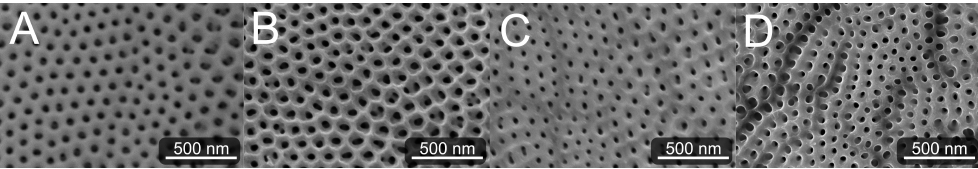
Figure 1. Scanning electron microscope (SEM) images of examined pristine TNSs ( A ) and TNSs implanted with 8 × 10 14 ions · cm − 2 ( B ), 1 × 10 16 ions · cm − 2 ( C ), and 2 × 10 16 ions · cm − 2 ( D ). The inner tube radius decreases from ( A – D ) due to irradiation-induced viscous material flow, as specified in